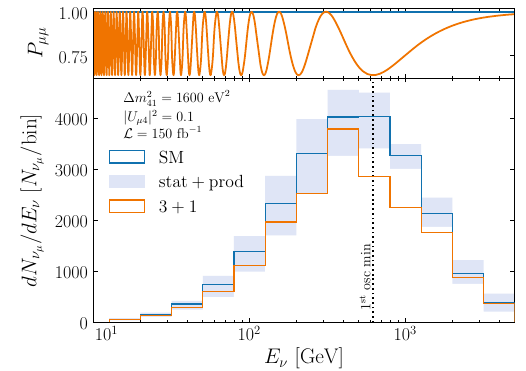
Fig. 21 Upper panel : The ν μ disappearance oscillation probability in the SM (blue) and in the presence of a sterile neutrino with (cid:17) m 2 1 , 600 eV 2 and | U μ 4 | 2 = 0 . 1 (orange). Lower panel : The expected ν μ event rate at FASER in the SM (blue) and in the presence of a sterileneutrinowiththesameparameters.Thestatisticalandproduction uncertainties (added in quadrature) are shown in the blue shaded region. The location of the first oscillation minimum is marked with a dotted